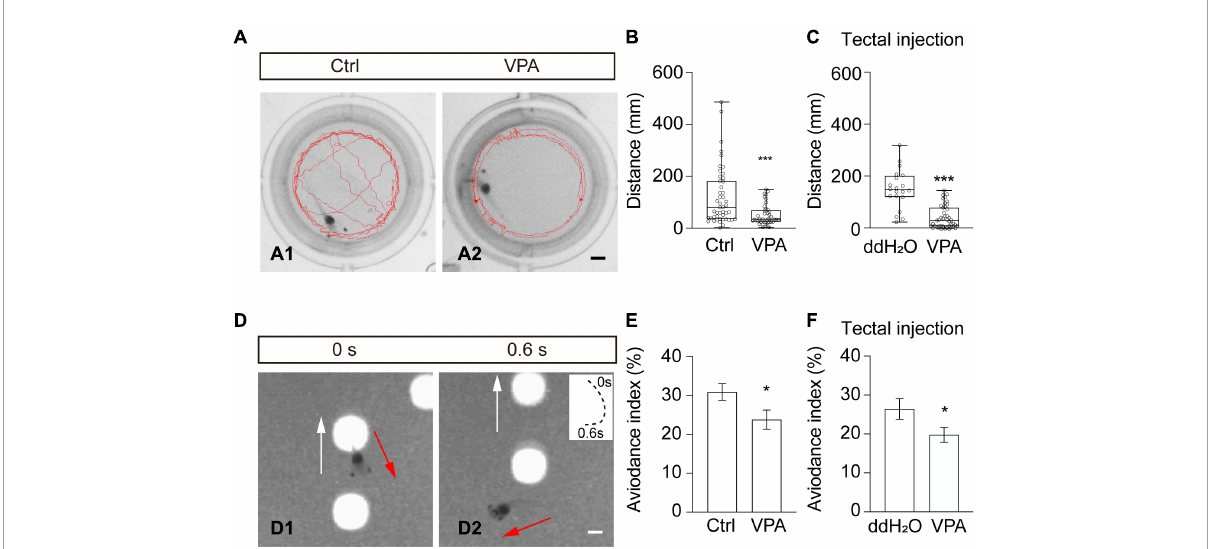
FIGURE6 Valproate acid-reared tadpoles show impaired free-swimming and visual avoidance behaviors. (A) Representative images showing the swimming traces of a tadpole within 60 s in Ctrl (left) and VPA-reared (right) tadpoles. Scale bar = 2 mm. (B) Summary of data showing the total swimming distance was decreased in VPA-raised tadpoles compared to ctrl tadpoles. (Ctrl, 120.3 ± 16.3 mm, N = 47; VPA, 51.1 ± 6.3 mm, N = 41; *** p < 0.001). (C) The data summary shows that the total swimming distance decreased in VPA-injected tadpoles compared to ddH 2 O-injected tadpoles. (ddH 2 O, 187.4 ± 16.9 mm, N = 20; VPA, 78.5 ± 6.5 mm, N = 45; *** p < 0.001). (D) A sequence of time-lapse images shows that a tadpole makes an avoiding turning in response to a moving spot (4 mm diameter) within 0.6 s. White arrows indicate the moving direction of the spot. Red arrows indicate the turning direction of the tadpole. The panel on the upper right shows the swim trajectories of the animal, with the start point marked as 0 s and the end point marked as 0.6 s. Spot luminance: 90 cd/m 2 . Scale bar = 2 mm. (E) Summary of data showing that the avoidance index (AI,%) was significantly decreased in VPA-treated tadpoles compared to Ctrl tadpoles. (Ctrl, 30.8 ± 2.2, N = 24; VPA, 23.8 ± 2.5, N = 24; * p < 0.05). (F) The data shows that the avoidance index was significantly decreased in VPA-injected tadpoles compared to ddH 2 O-injected tadpoles. (ddH 2 O, 28.5 ± 2.8, N = 20; VPA, 21.1 ± 2.0, N = 36; * p < 0.05). N represents the number of